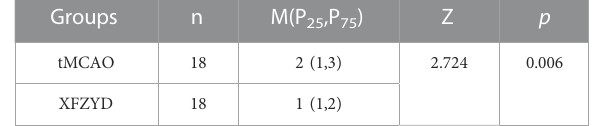
TABLE 2 Comparison of neurological de fi cit scores in tMCAO and XFZYD groups.